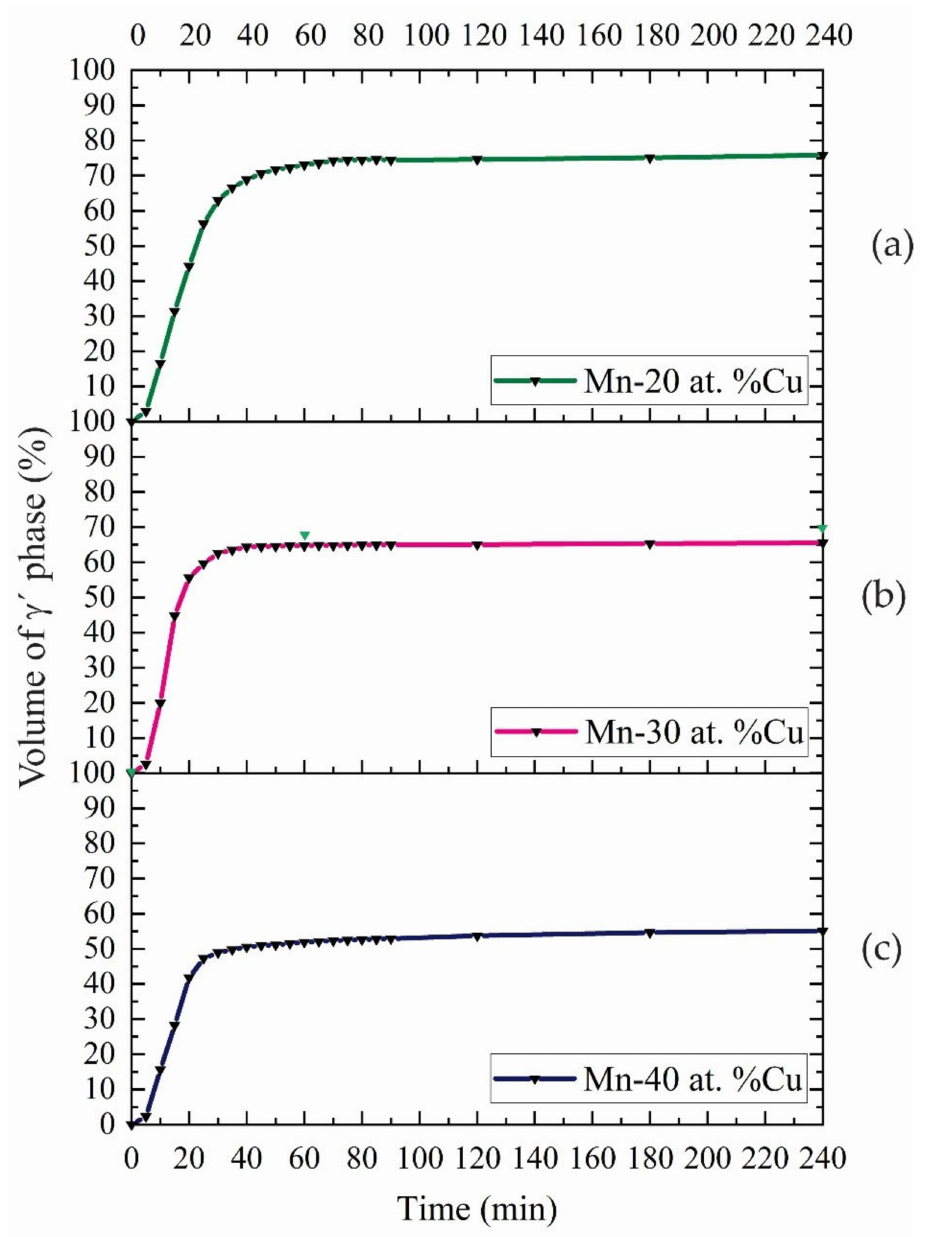
Figure 8. Volume fraction of γ (cid:48) phase for ( a ) Mn-20 at. %Cu, ( b ) Mn-30 at. %Cu, and ( c ) Mn-40 at. %Cu alloys aged at 500 ◦ C. The green marks in ( b ) represent the experimental results of Vitek and Warlimont